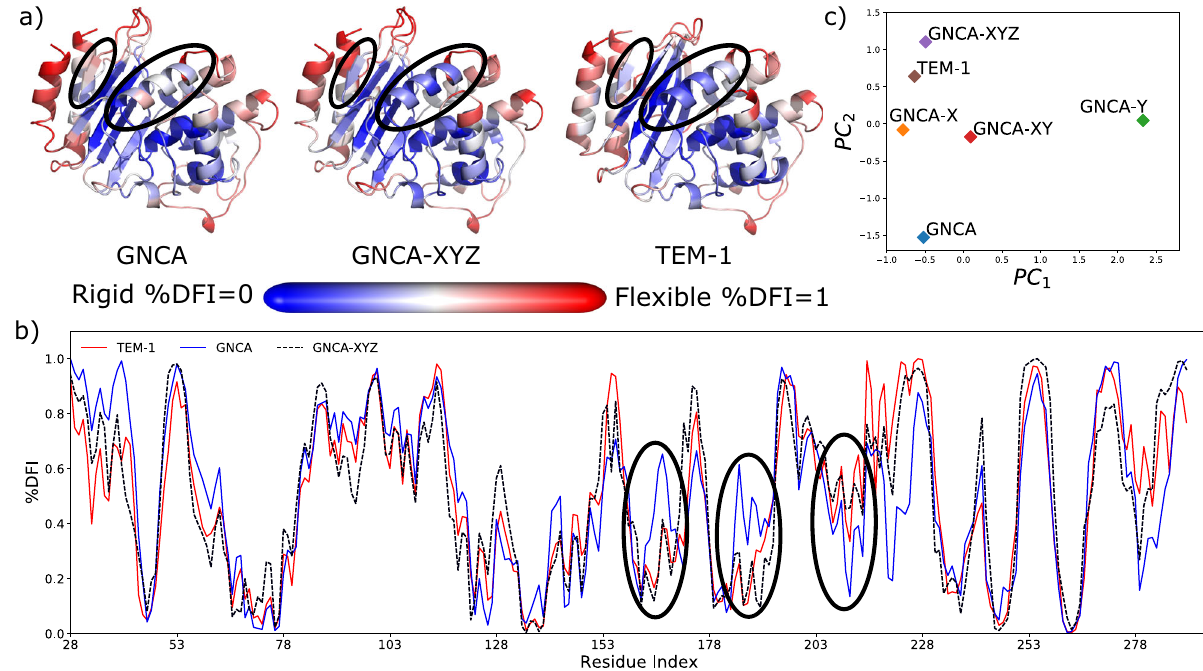
Fig. 4 Substitutions from set Z bring the dynamics of GNCA-XY closer to TEM-1. Comparison of the fl exibility pro fi le of wild-type GNCA and TEM-1 β - lactamase with the GNCA mutants created by performing mutations from set Z over GNCA-XY (GNCA-XY) as a color-coded DFI pro fi les mapped onto the 3D structure where red-colored residues are fl exible and blue are rigid, b clustering of these pro fi les using principal component analysis, c the plot of mapped DFI pro fi les per residue position for each protein. The PCA analysis presents that GNCA-XYZ is the closest to TEM-1 β -lactamase, when their difference is plotted in biplot using the fi rst two principal eigenvectors. As observed per position DFI plot, GNCA-XYZ very closely mimics the fl exibility pro fi le of TEM-1 β -lactamase, particularly ~185, 155, 210, and the C terminus (highlighted regions in b ). This is also seen in their cartoon representations ( a ). The computed data are provided as a Source Data fi